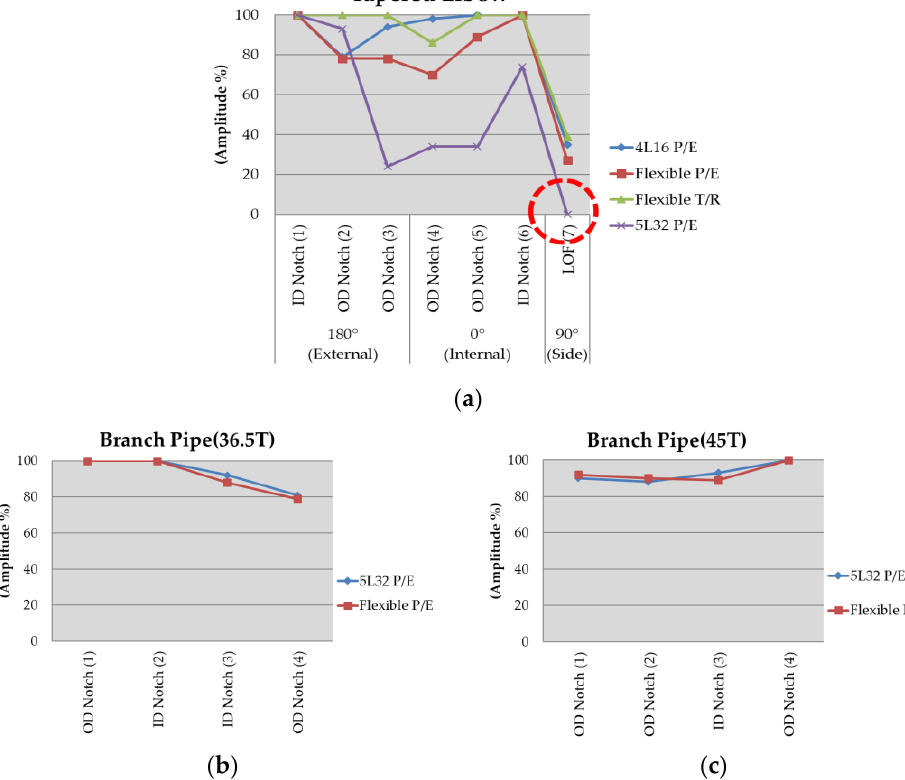
Figure 23. Tapered elbow and branch specimen inspection results: ( a ) tapered elbow, ( b ) branch pipe, ( c ) branch pipe.